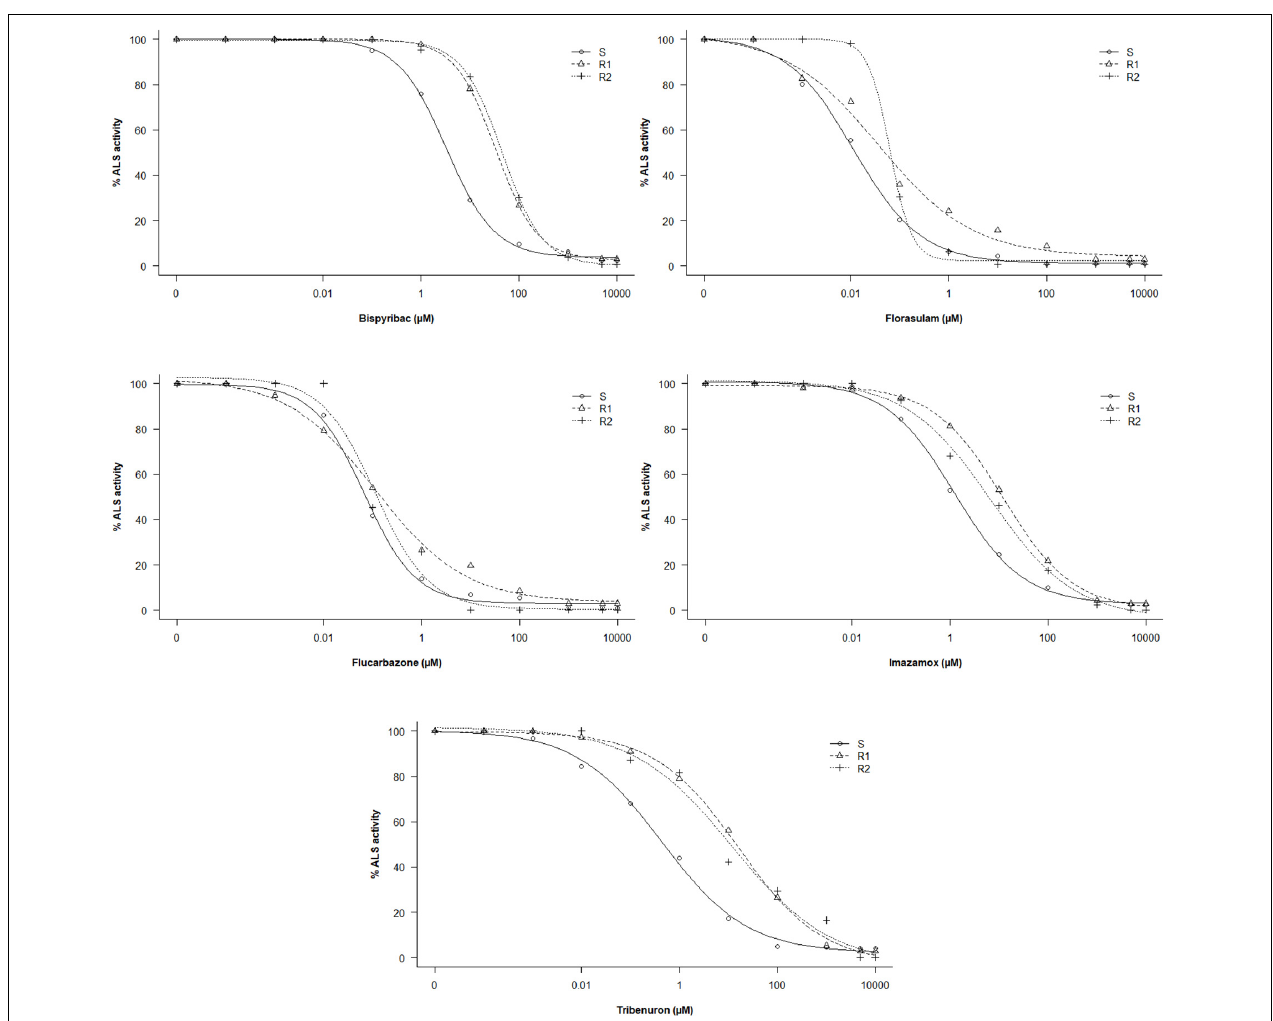
FIGURE 2 | Dose–response curves of the ALS enzyme activity of G. coronaria populations exposed to increased concentrations ( µ M) of five